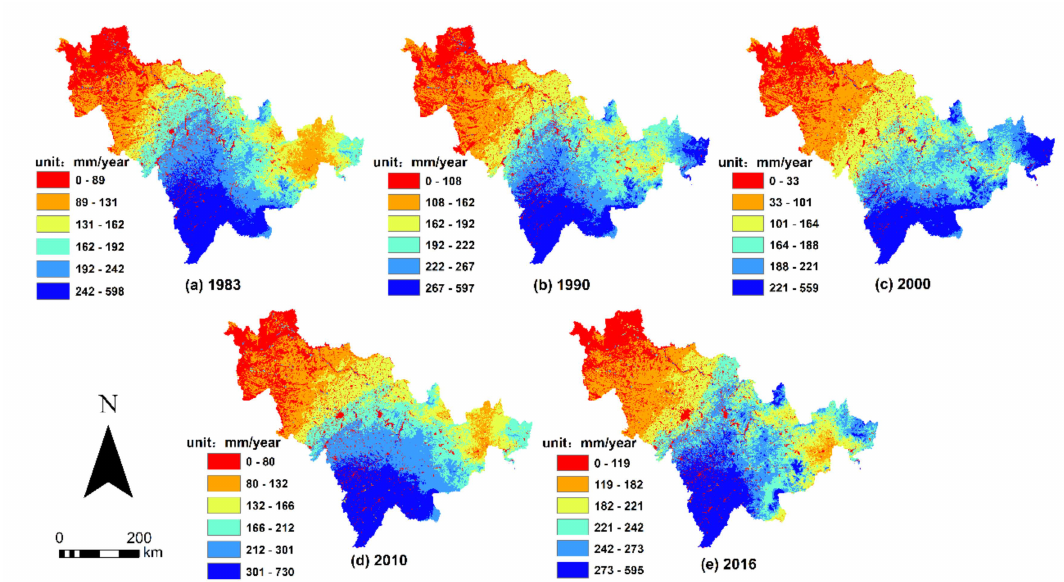
Figure 6. The water conservation spital-temporal distribution pattern of Jilin province in ( a ) 1983, ( b ) 1990, ( c ) 2000, ( d ) 2010, and ( e ) 2016.